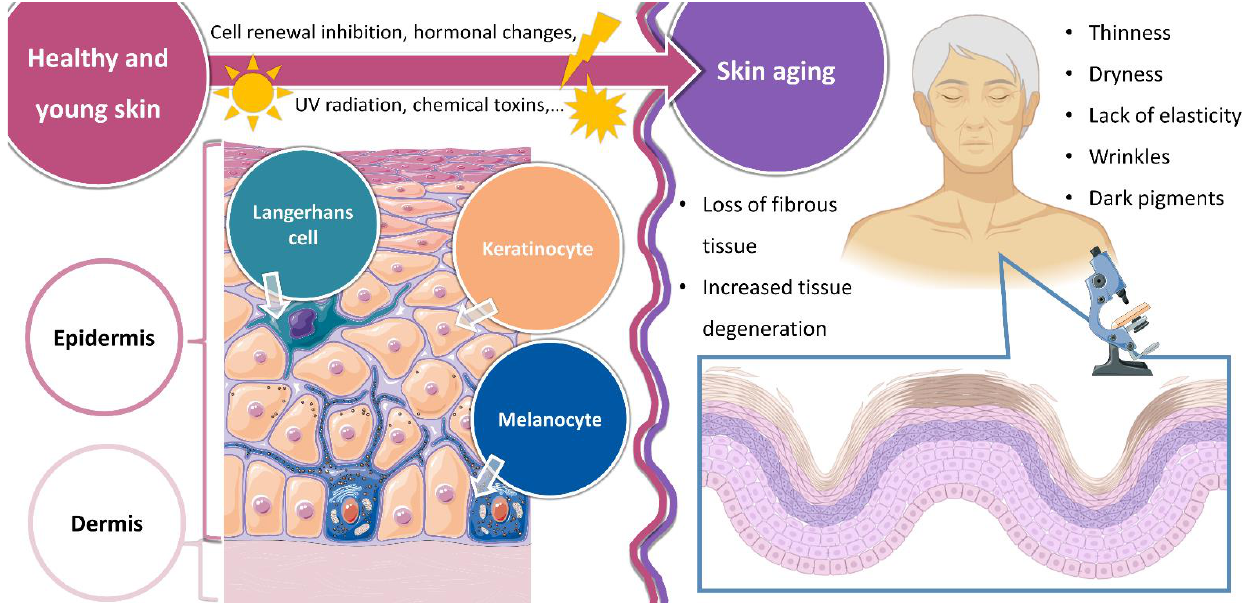
Figure 1. Main skin structure and composition, intrinsic and extrinsic factors that lead to skin aging, and main changes in skin characteristics due to aging (produced with BioRender).